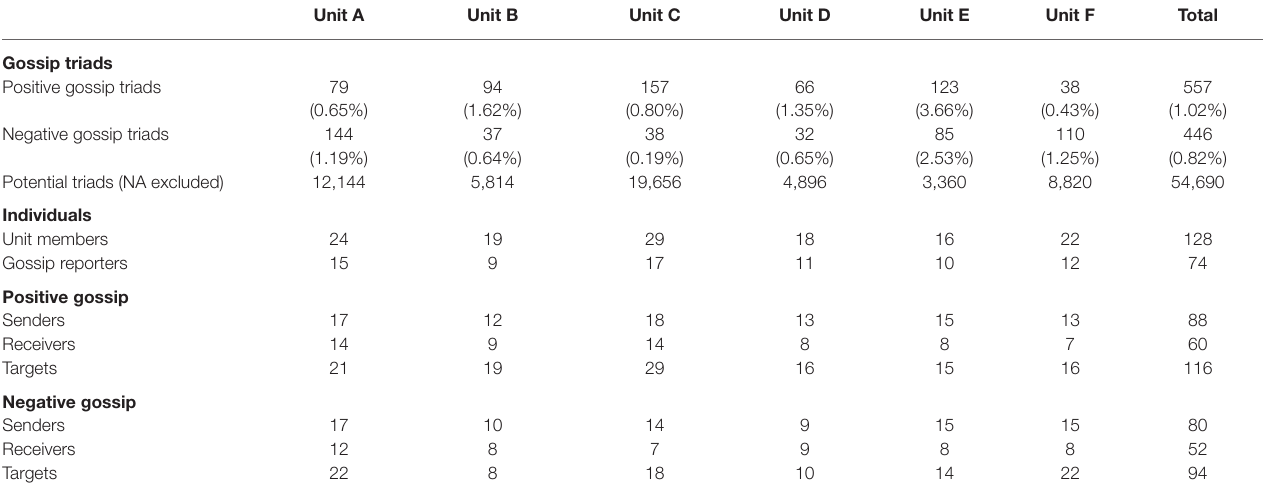
TABLE 1 | Summary statistics of